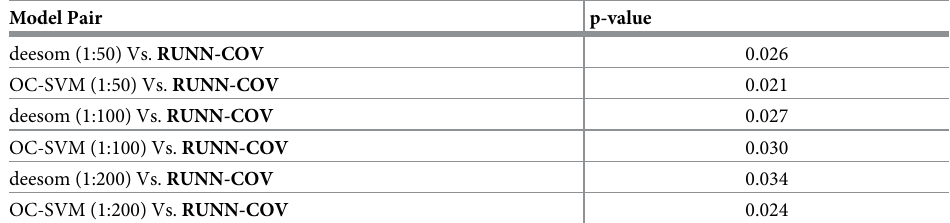
Table 4. RUNN-COV model against previous studies paired sample t-test (significance level of 0.05).